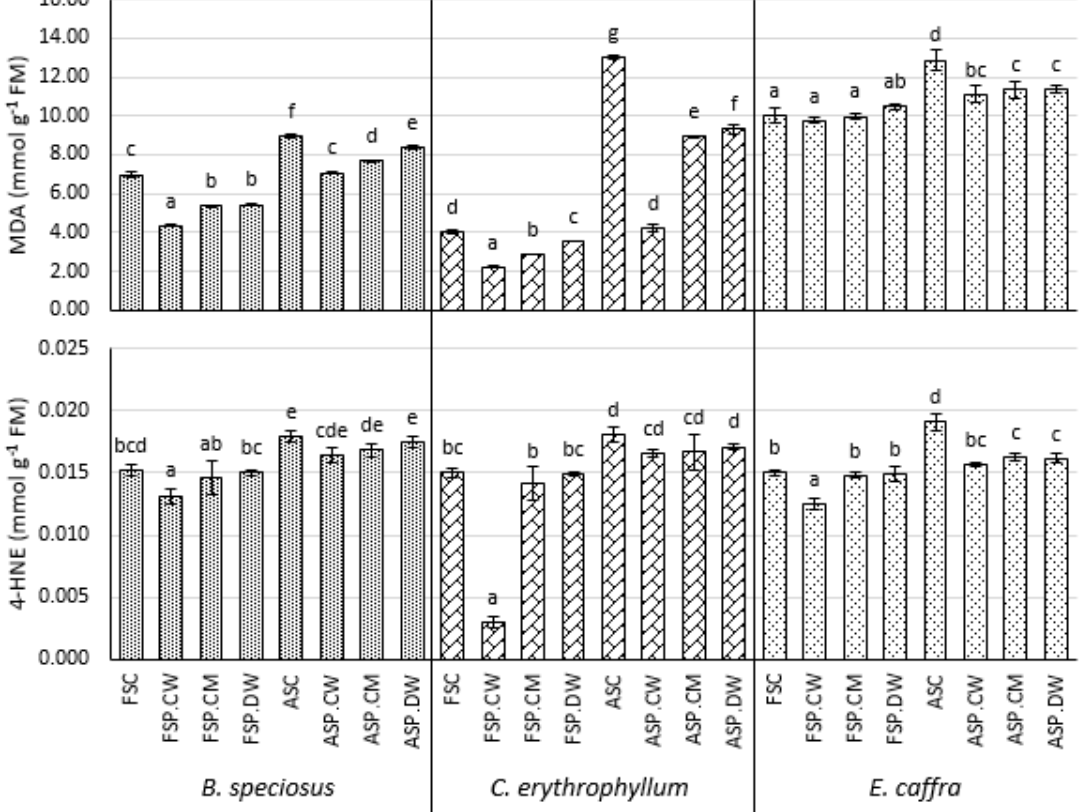
Figure 4. Effect of cathodic water, calcium magnesium solution and deionized water seed invigoration on MDA and 4-HNE contents in the seeds of Bolusanthus speciosus, Combretum erythrophyllum and Erythrina caffra . Bars with different letters in each species and for each parameter (MDA/4-HNE, 4-hydroxynonenal and malondialdehyde respectively) investigated are significantly different ( p < 0.05). Abbreviations as for Figure 1.